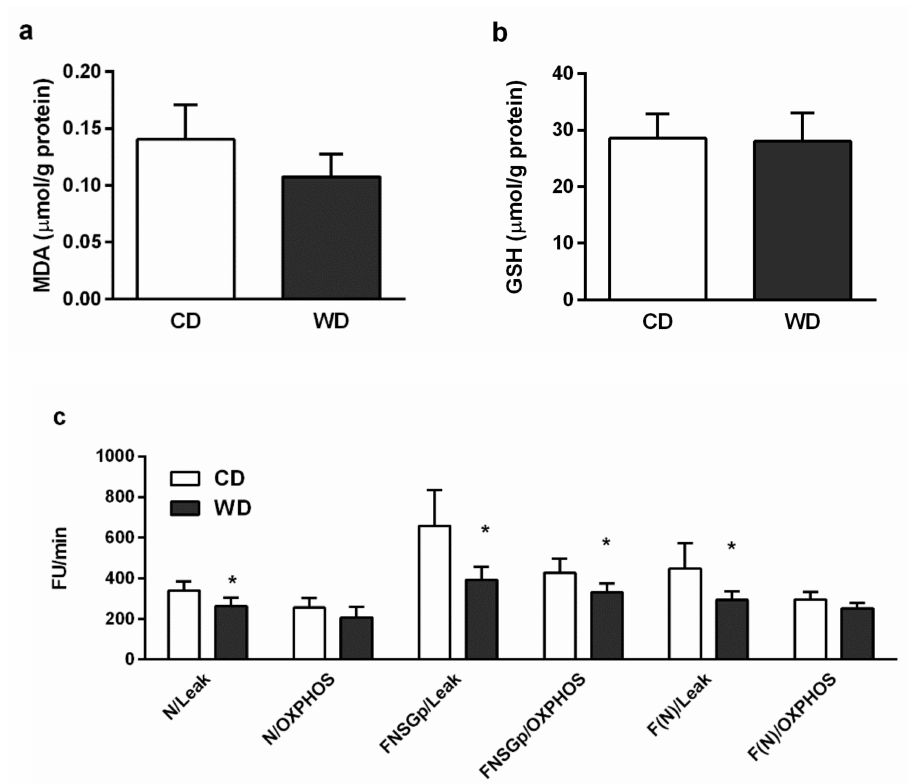
Figure 7. Markers of hepatic oxidative stress in mice fed a control diet (CD) and a Western-style diet (WD). ( a ) Concentration of hepatic malondialdehyde (MDA). ( b ) Concentration of hepatic reduced glutathione (GSH). ( c ) Reactive oxygen species (ROS) production in liver homogenate measured as fluorescence changes in dichlorofluorescein. LEAK, measurements in the absence of adenosine diphosphate (ADP); oxidative phosphorylation (OXPHOS), measurements in the presence of ADP (2.5 mM); N, NADH-linked substrates (pyruvate, 5 mM; glutamate, 10 mM; malate, 2 mM); FNSGp, fatty acid (octanoylcarnitine, 0.5 mM) plus NADH-linked substrates plus succinate (10 mM) and glycerophosphate (10 mM); F(N), octanoylcarnitine (0.5 mM) plus malate (2 mM). The results are expressed as the means ± SD; * p < 0.05 ( n = 6 each